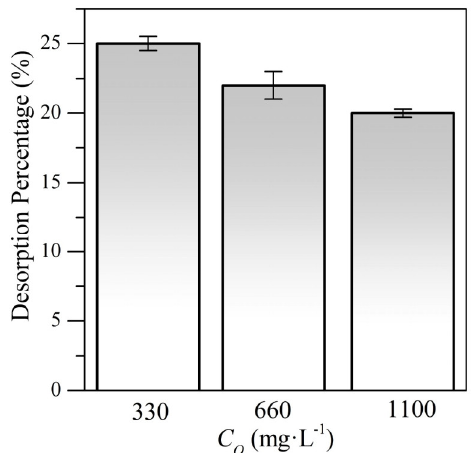
Figure 8. Percentages of desorption for different initial concentrations ( C 0 ) of CTAB and a fixed concentration of MgO nanoparticles (1100 mg·L −1 ) for system II at 25 °C.